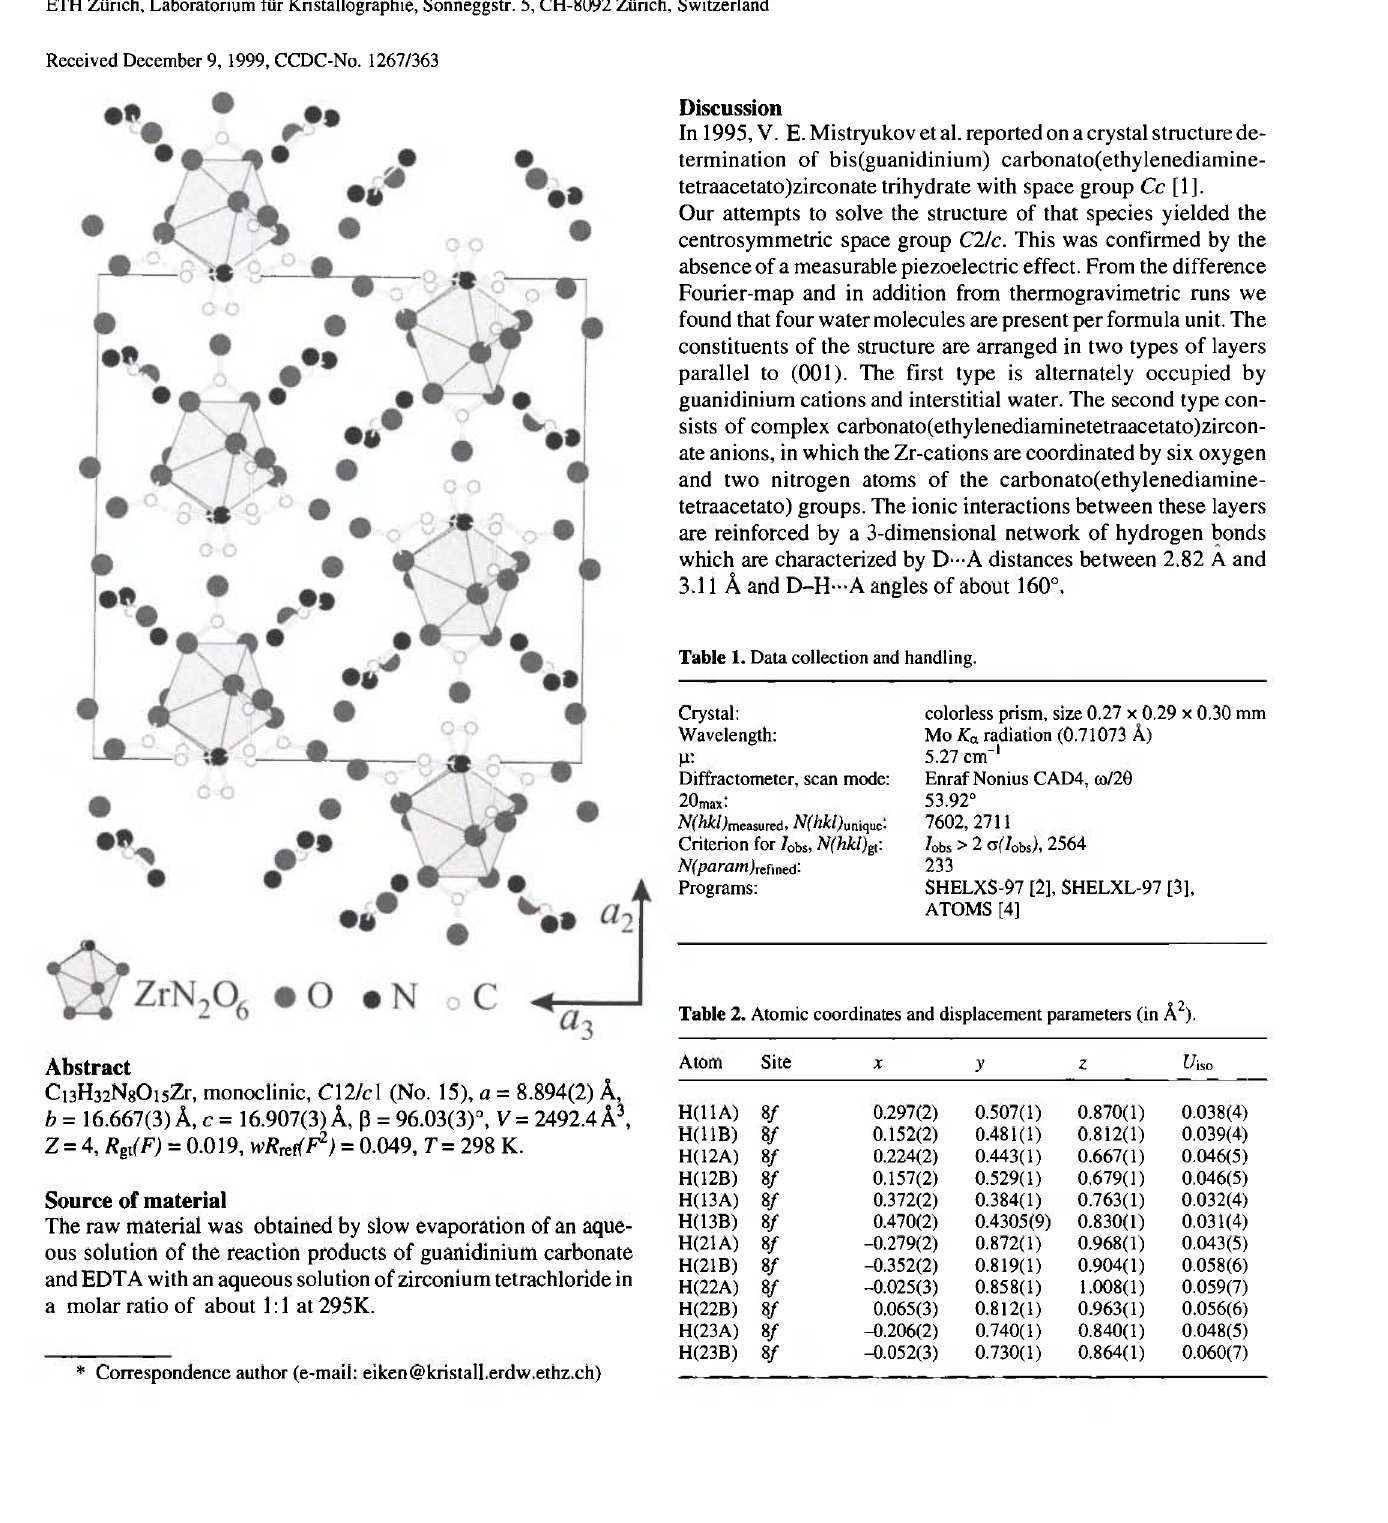
Table 2. Atomic coordinates and displacement parameters (in Ä 2